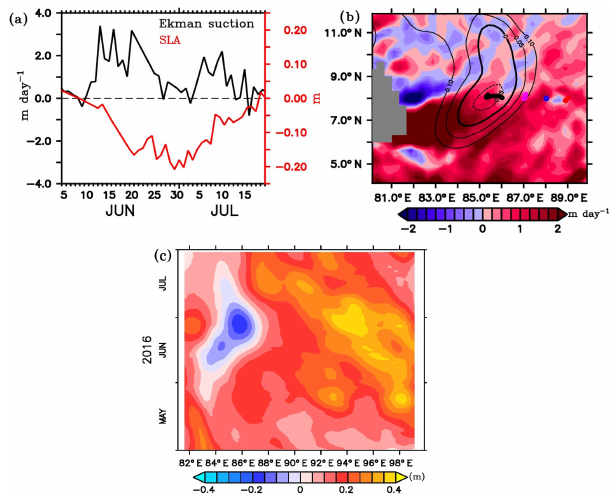
Figure 6. (a) Time series of Ekman vertical velocity (mday − 1 ; black) around the location of SG579 (85–86 ◦ E, 7.5–8.5 ◦ N), and the minimum SLAs (m; red) in the region of the Sri Lanka Dome (SLD) from 5 June to 20 July. (b) Ekman vertical velocity aver- aged for the BoBBLE observational period (24 June–23 July) in the southern BoB. Contours of SLAs are overlayed. (c) Time–longitude Hovmöller diagram of SLAs along 8 ◦ N between 81 and 100 ◦ E from May to